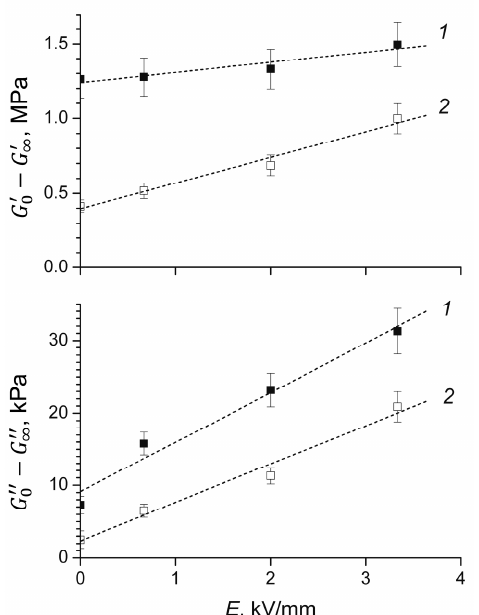
Figure 3. The e ff ect of the external electric field strength on the value of the Payne e ff ect for the storage Figure 3. The effect of the external electric field strength on the value of the Payne effect for the storage (cid:48)(cid:48) − G (cid:48) − G (cid:48)(cid:48) modulus ( G (cid:48) ∞ ) for the ERE-0 and ERE-5 ∞ ) and loss modulus ( G 0 0 modulus ( 𝐺 (cid:2868)(cid:4593) − 𝐺 (cid:2998)(cid:4593) ) and loss modulus ( 𝐺 (cid:2868)(cid:4593)(cid:4593) − 𝐺 (cid:2998)(cid:4593)(cid:4593) ) for the ERE-0 and ERE-5 samples.